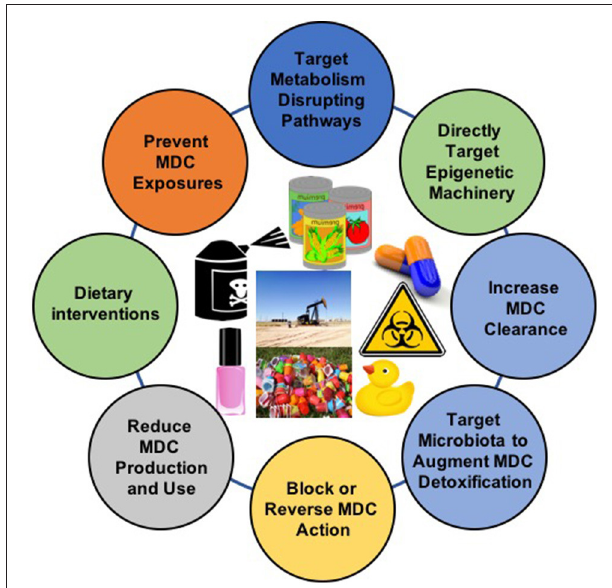
FIGURE 2 | Interventions to Address Exposure to Metabolism-Disrupting Chemicals (MDCs). The diversity of MDCs and their effects require comprehensive approaches to address this underappreciated metabolic disease risk factor. Images from pixabay.com and